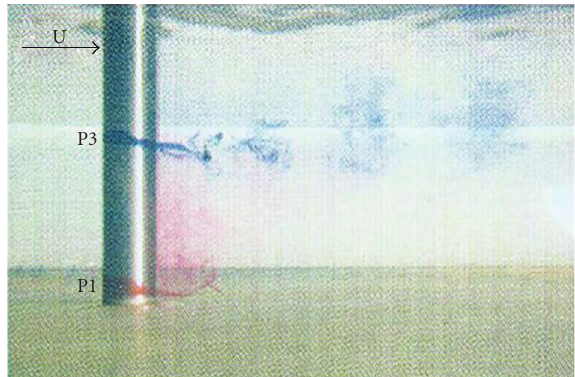
Figure 5: Qualitative demonstration of the dynamics of horse- shoe vortex around a circular cylinder as the source of three- dimensionality of shallow wake (Reproduced by permission from Visualization Society of